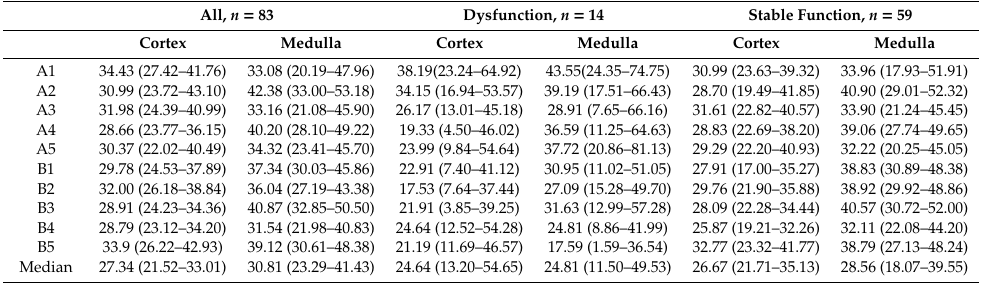
Table 4. Variability analysis of Young’s modulus between examinations by clinical classification of kidney allograft as dysfunction or stable